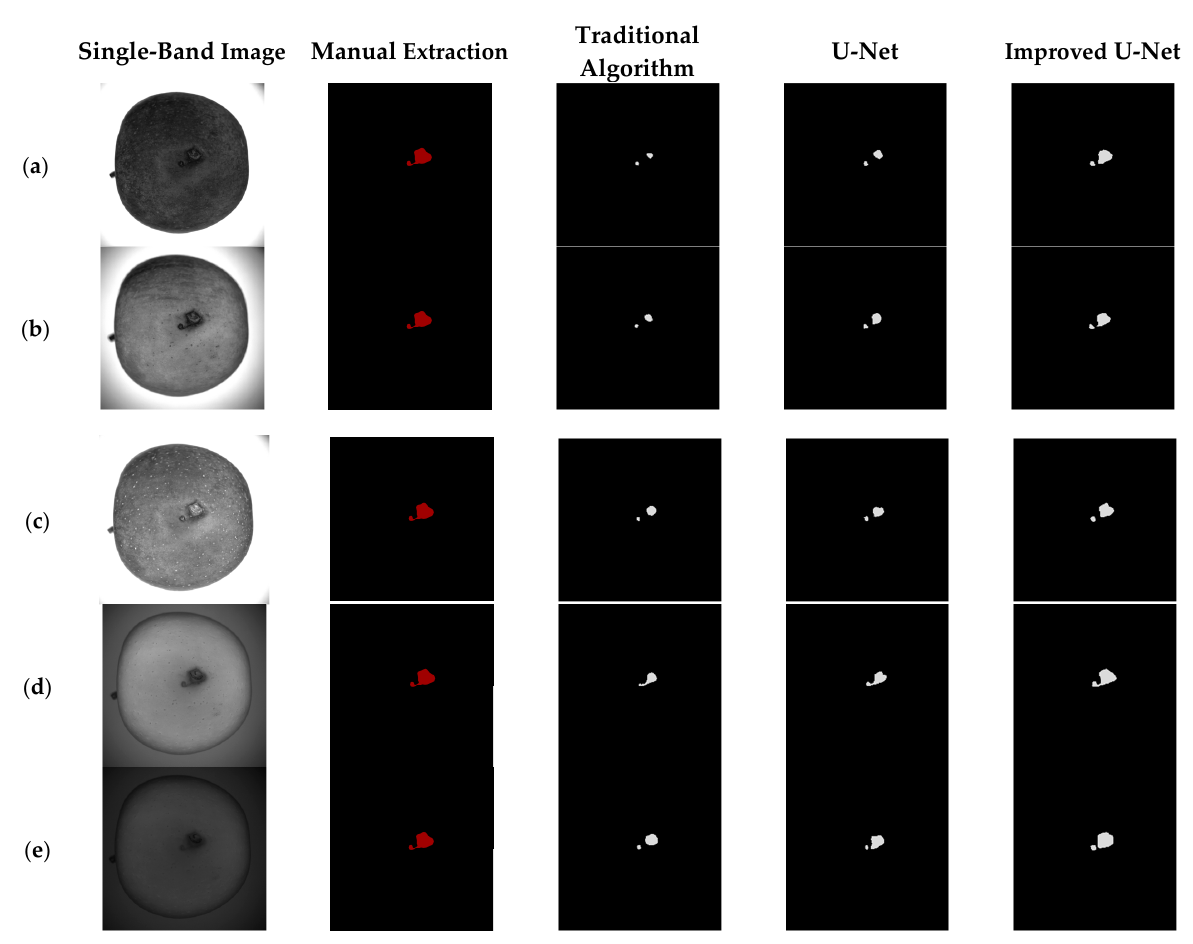
None Table 3. mF1-score of the traditional algorithm, U-Net, and improved U-Net. 460 nm